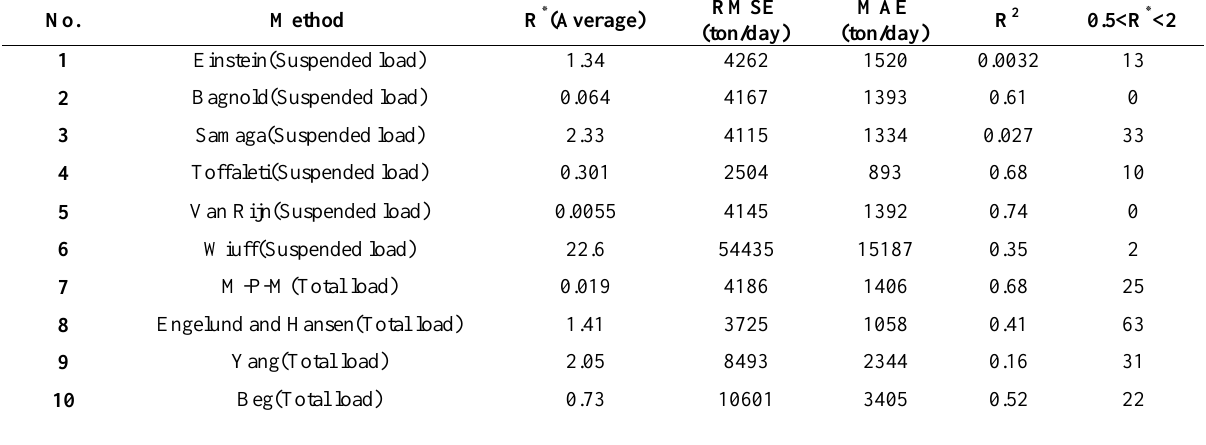
Table 3. Comparison between computed and measured sediment load of the Karun